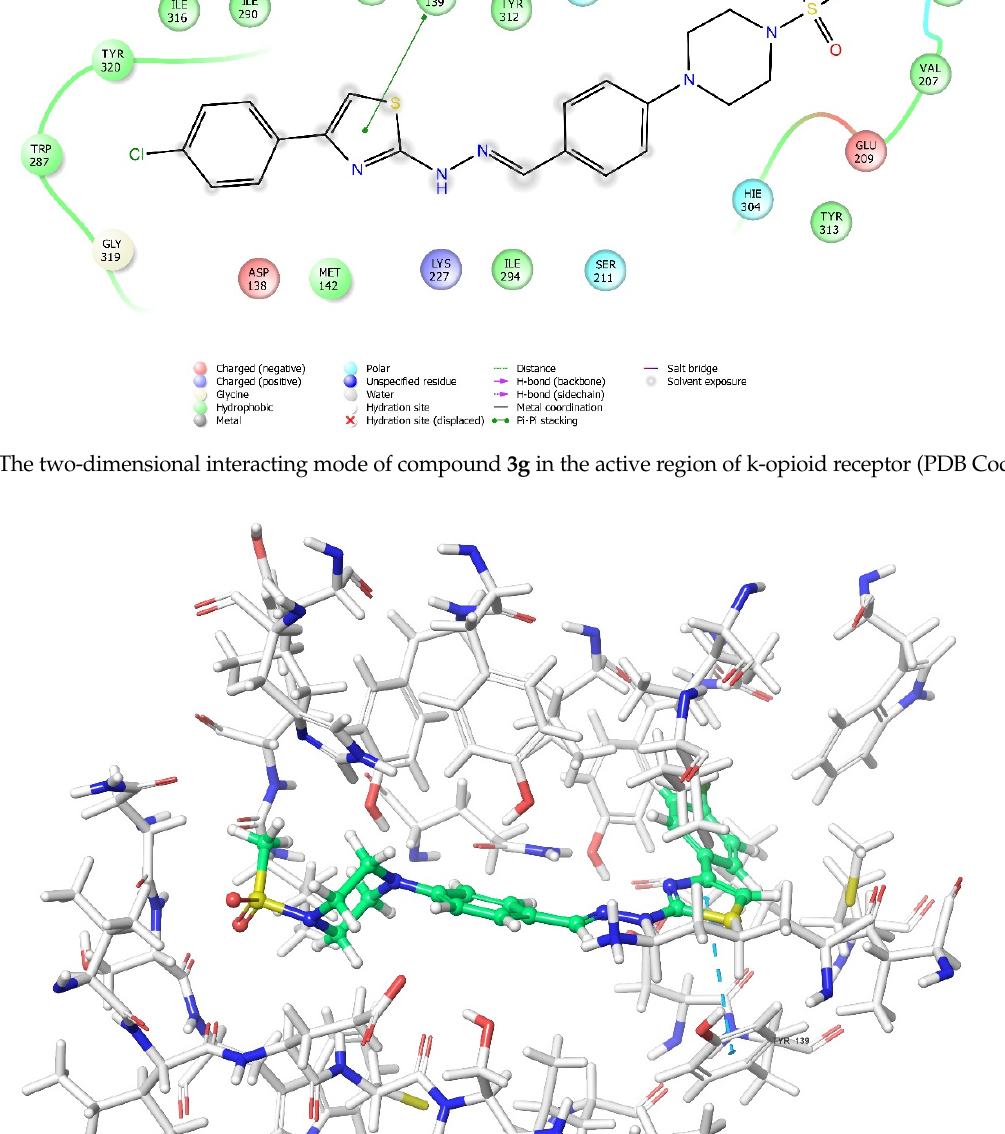
Figure 24. The three-dimensional interacting mode of compound 3g in the active region of k-opioid receptor. The ligand and significant residues of the active site of the receptor are presented by a tube model colored with green and white, respectively (PDB Code: 6B73).